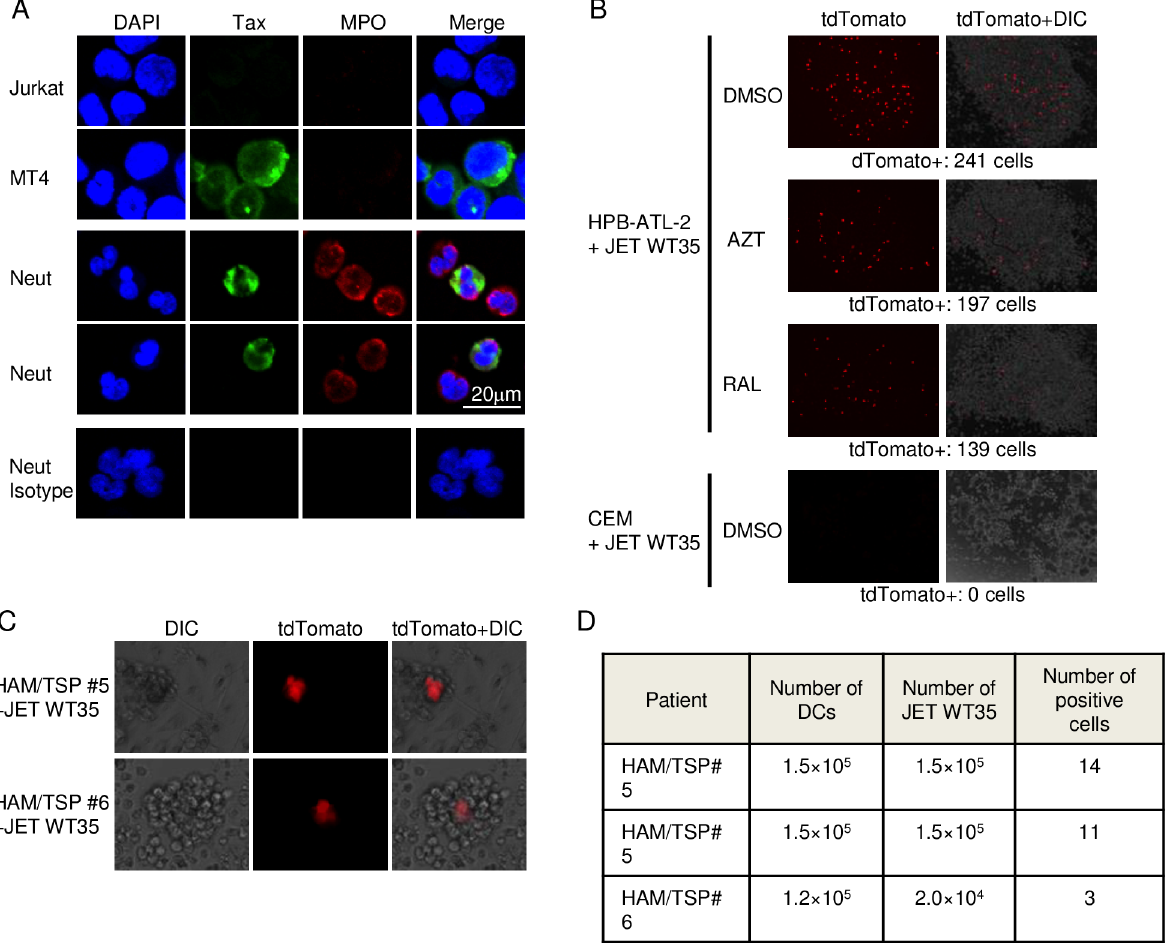
Fig 4. HTLV-1 infection in neutrophils and monocytes. (A) Tax expressionis detected by confocal immunofluorescence microscopy in MT4 and neutrophilsfrom HAM/TSP patients using anti-Tax antibodyand secondary Alexa Fluor 488 antibody. Myeloperoxidase expression is also detected in neutrophilsusing anti-MPO antibodyand secondaryAlexa Fluor 568 antibody.Jurkat was used as a negativecontrol. MT4, HTLV-1 infected cell line; Jurkat cells, HTLV-1 negativehumanT-cell line. DAPI (blue) was used for nuclei staining.(B) JET WT35 cells were co-cultured with HPB-ATL-2 cells in the presenceand absenceof azidothymidine (AZT) or raltegravir (RAL), or HTLV-1 uninfectedT cell line, CCRF-CEM. The number of tdTomato-positive cells is presented. (C) Dendriticcells were inducedfrom monocytes from HAM/TSP patients, and then differentiated DCs were co-culturedwith JET WT35. After 48 hours, newly infected JET WT35 was shown to be red. (D) Quantitative data of co-culture betweendifferentiated DCs and JET WT35 cells. The count of tdTomato positive cells and the number of cells used for this experimentare